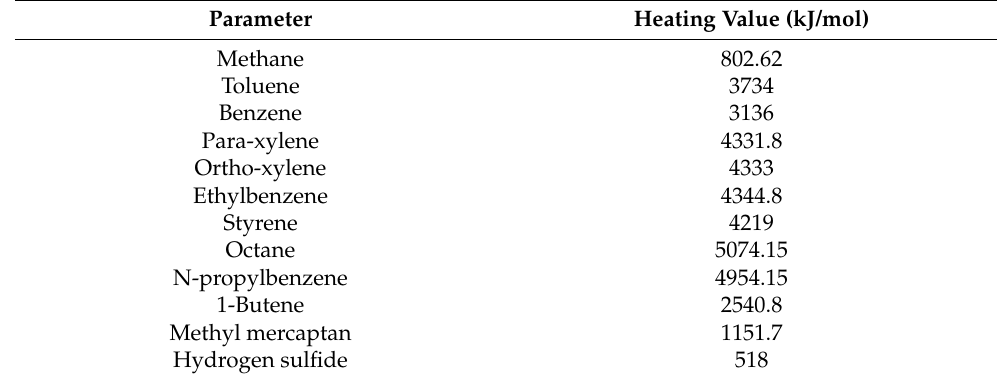
Table 4. Heating values for the